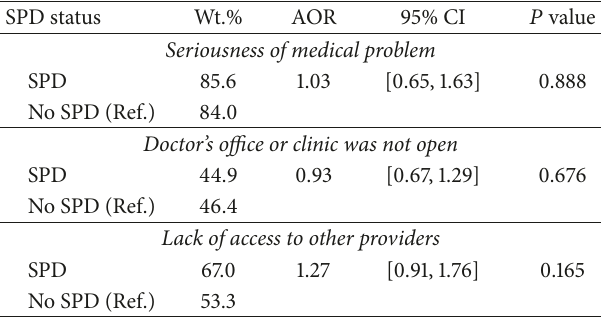
Table 3: Weight row percentages, adjusted odds ratios, and 95% confidence intervals of serious psychological distress from separate logistic regressions on reasons of the recent ER use in the past 12 months. Adults with multimorbidity and ER use. National